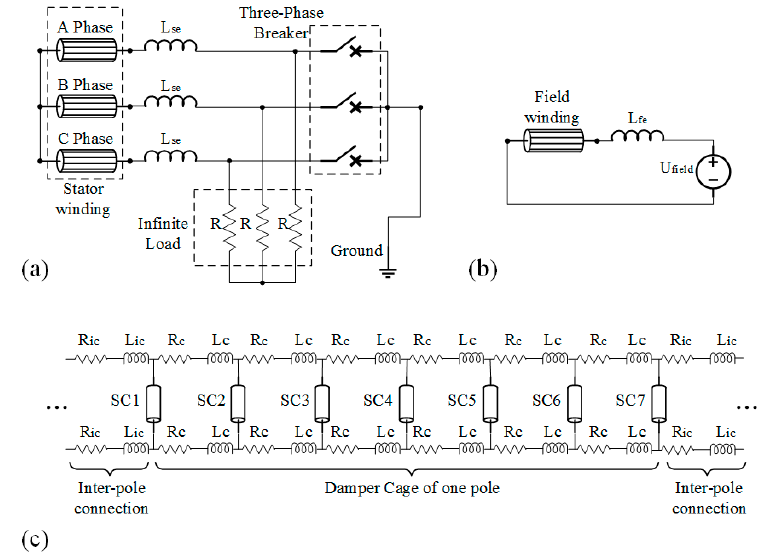
Figure 4. 2-D FE model cross section of prototype.